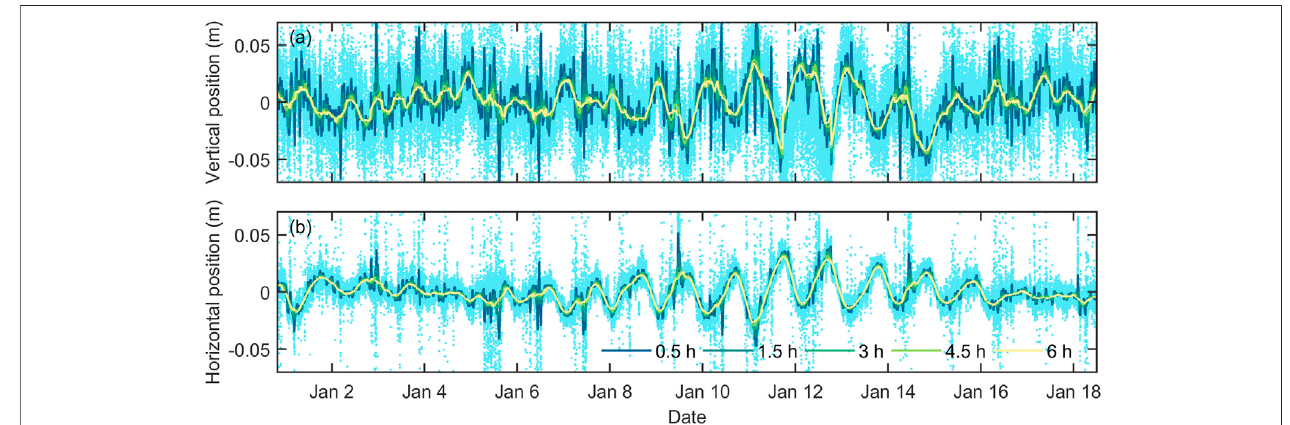
FIGURE 2 | Raw and smoothed GNSS observations of the (A) vertical and (B) across- fl ow position of the local GNSS station. The effects of different smoothing windows (coloured lines) are shown. Negative horizontal (across- fl ow) distances indicate displacement toward the glacier margin, and positive distances indicate displacement toward the glacier